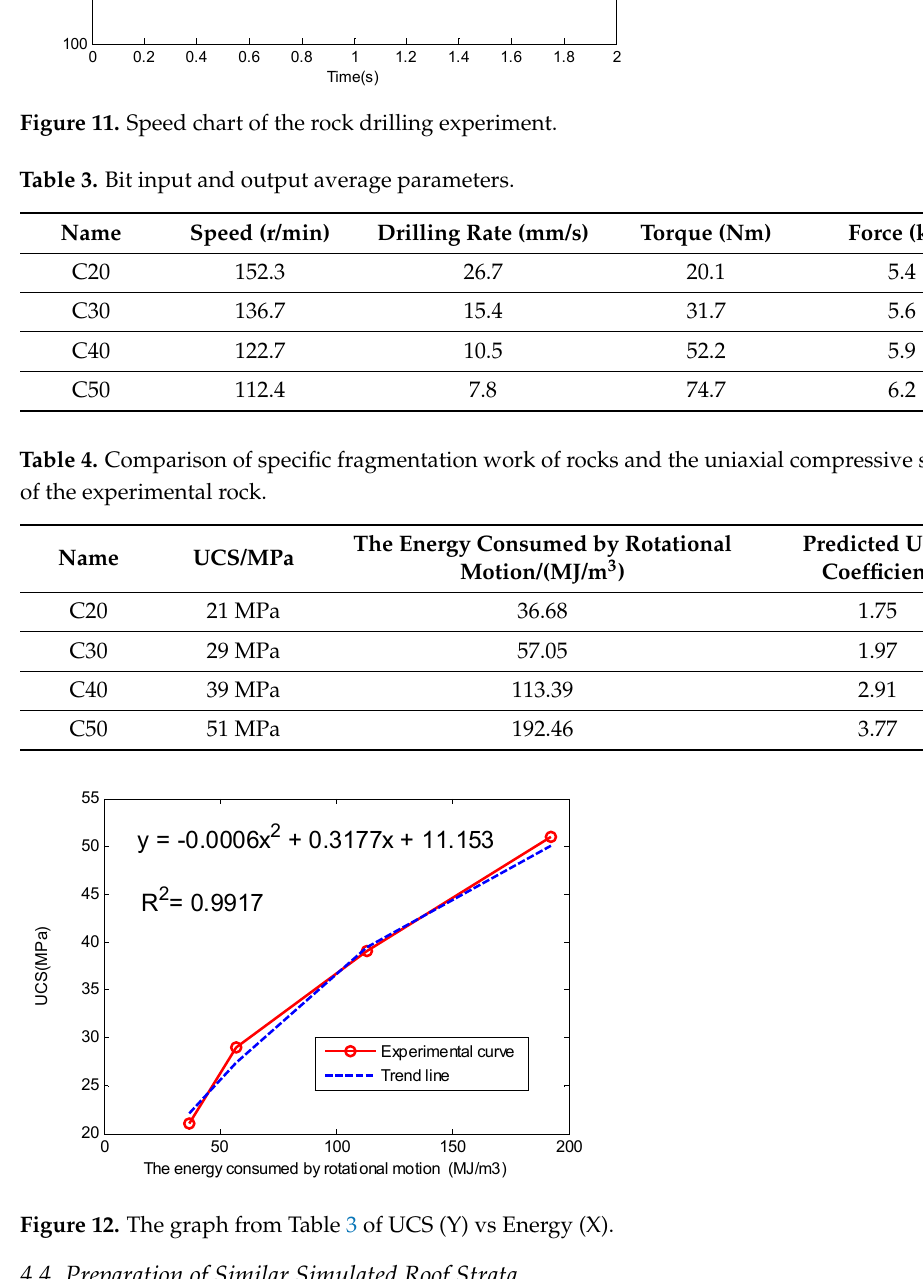
11 of 18 Figure 8. Drilling speed chart for bit drilling. Figure 9. Drilling experiment of the drill bit.